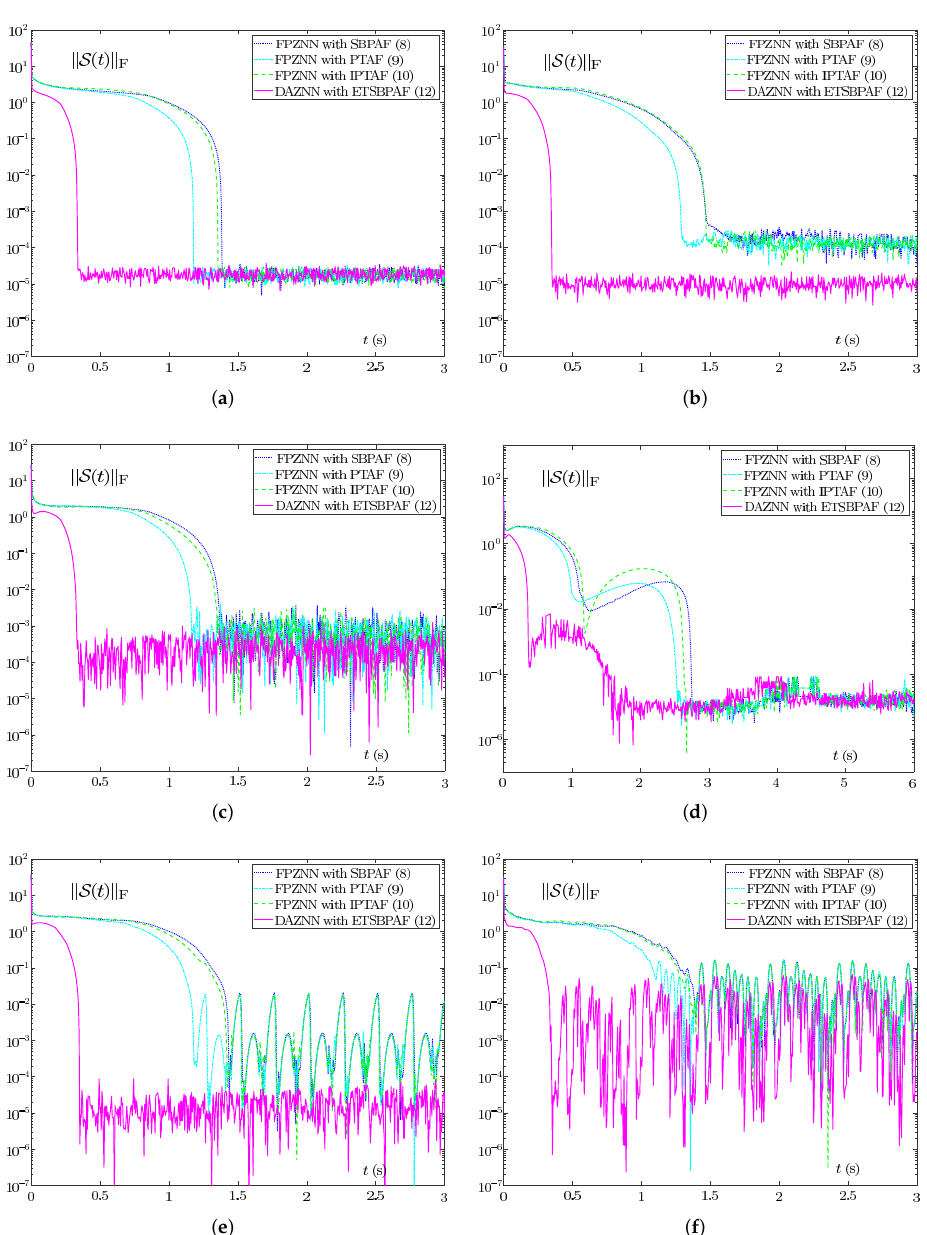
Figure 7. Dynamic characteristics of the (cid:107)S ( t ) (cid:107) F by FPZNN model (4) and DAZNN model (14) with no noise or disparate bounded noises. ( a ) No noise. ( b ) Constant noise ξ ij ( t ) = 0.8. ( c ) Gaussian noise. ( d ) Exponentially attenuated noise ξ ij ( t ) = exp ( − 1.2 t + 2 ) . ( e ) Harmonic noise ξ ij ( t ) = sin ( 4 π t + π ) . ( f ) Blended harmonic noise ξ ij ( t ) = sin ( 10 π t − π ) + sin ( 30 π t + 3 ) + sin ( 34 π t − 4 ) + sin ( 50 π t + 7 )